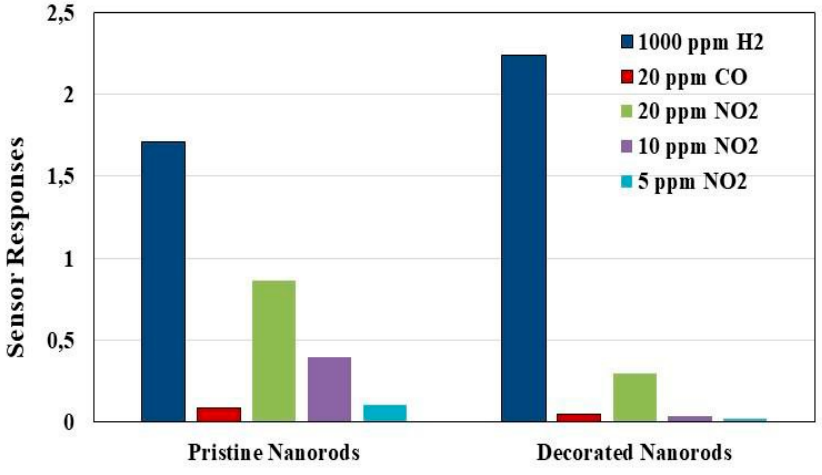
Figure 3. Sensor responses of pristine and decorated CuO nanorods againts H 2 , CO and NO 2